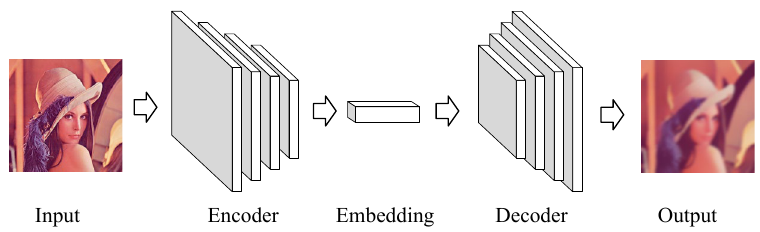
Figure 2. Structure of a typical encoder-decoder network.